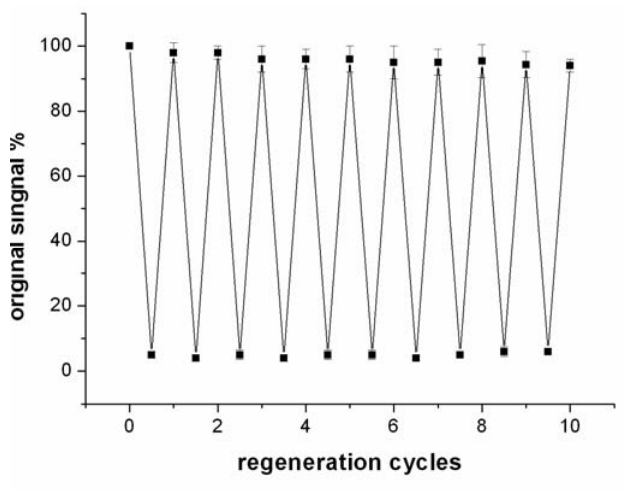
Figure 7. Reusability of the QCM-based Hg 2+ sensor challenged with 5 nM Hg 2+ and washed with 50 mM